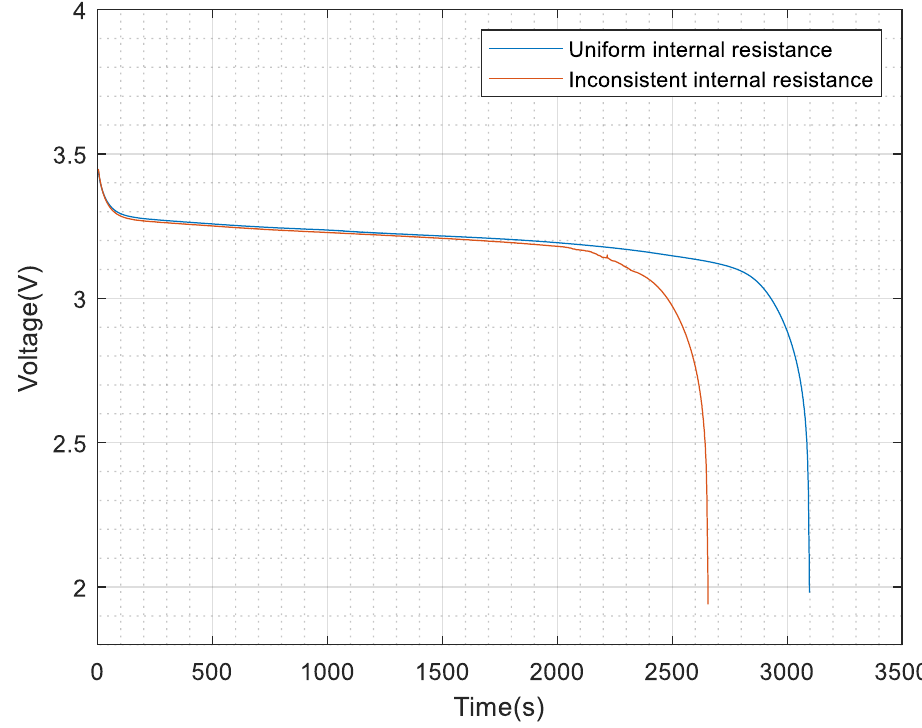
Figure 3. The influence of the consistency of the internal resistance of the battery cell on the battery group.